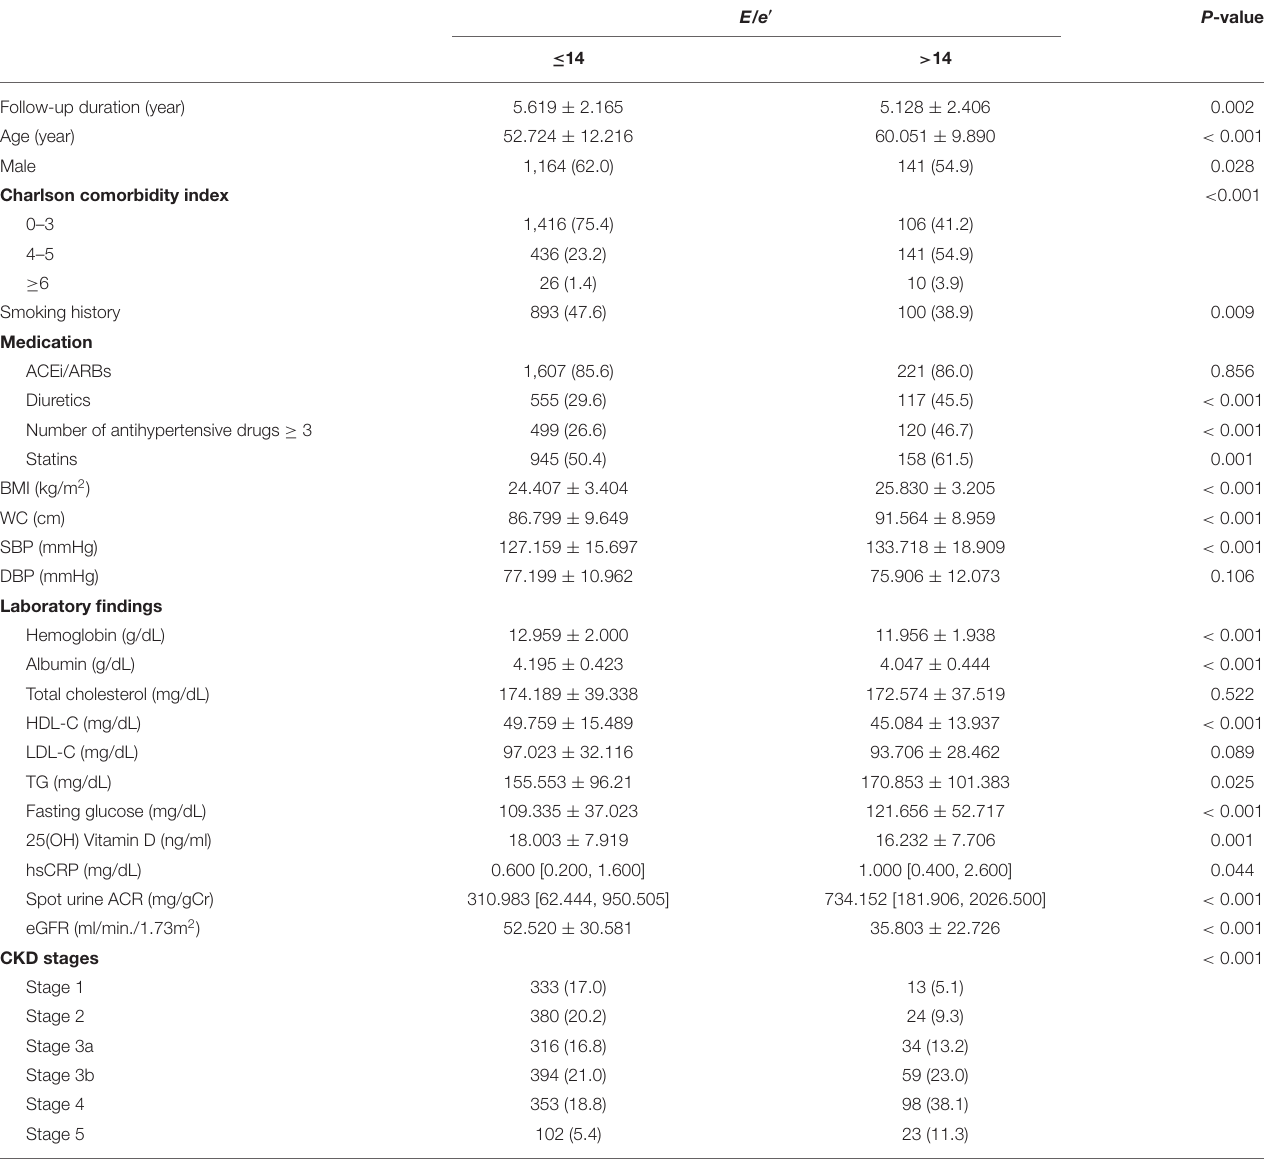
TABLE 1 | Baseline characteristics of study participants by E / e ′